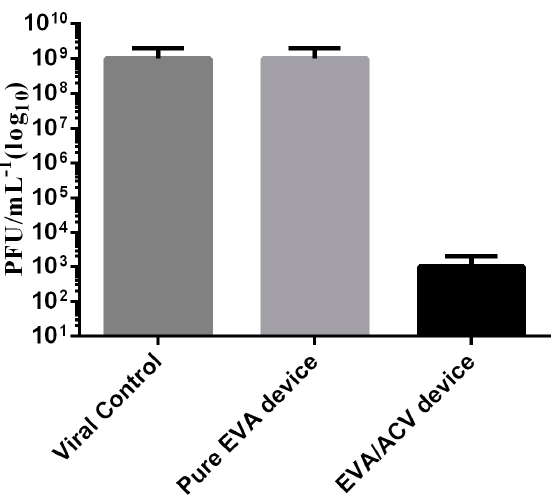
Figure 7. Antiviral activity against HSV-1, comparing the viral control, pure EVA device, and EVA device treated with ACV ( n = 3).